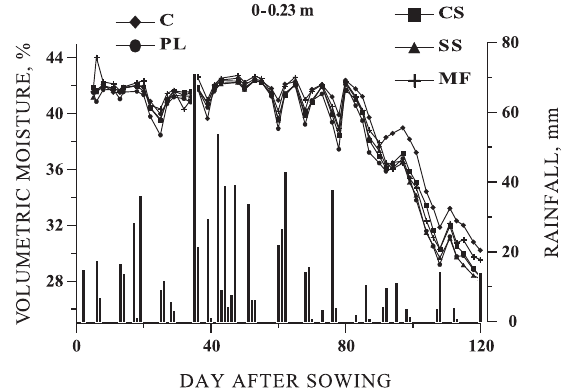
Figure 8. Volumetric moisture in the 0–0.23 m layer and rainfall (bars) during the corn cycle for five nutrient sources (averaged across tillage systems). (C: control; PL: poultry litter; CS: cattle slurry; SS: swine slurry; and MF: mineral